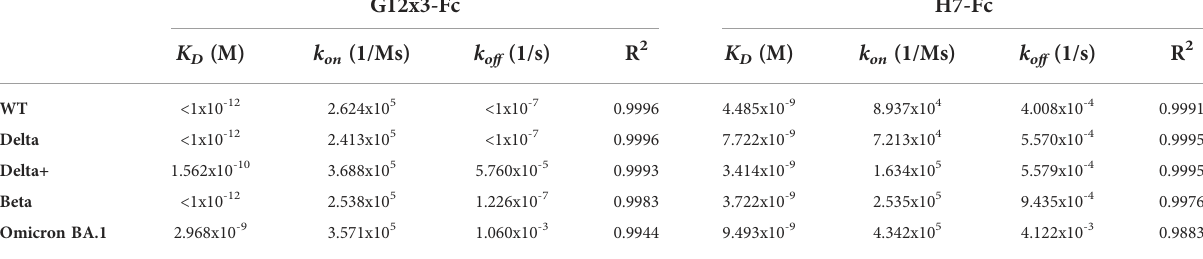
TABLE 1 Antibodies binding activity against RBD variants; related to Figure 6